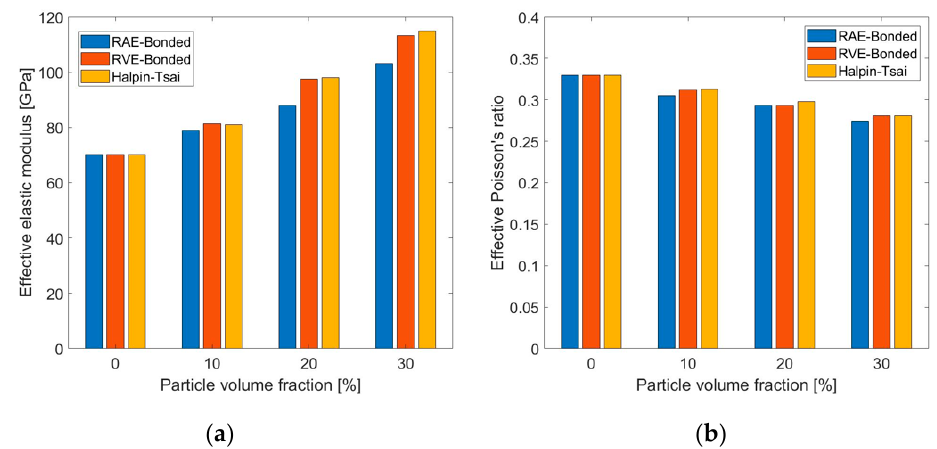
( c ) Figure 6. Effective elastic modulus ( a ) and Poisson’s ratio ( b ) obtained from RVEs under uniaxial tension ( c ) and fully bonded conditions for different particle volume fractions and loading direc- tions. Figure 6 shows that the representative RVE models can be regarded as isotropic for all examined particle volume fractions. The maximal relative deviation that was obtained for both the elastic modulus and Poisson’s ratio was 8.1%. Figure 6 also shows clear trends of the relation between the effective elastic properties and the particle volume fraction. The elastic modulus increased with increasing particle volume fraction, while Poisson’s ratio decreased with increasing particle volume fraction. Then, the 2D and 3D representative models were compared to examine the ability of RAE models to effectively predict the elastic properties. RAE models are easier to con-